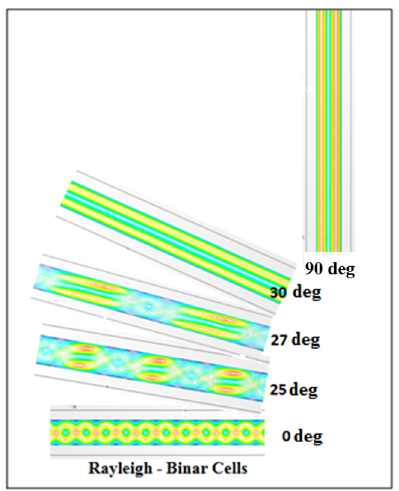
Figure 4. Change in airflow regime in the gap between the panes of a double-glazed window as a function of inclination angle β .